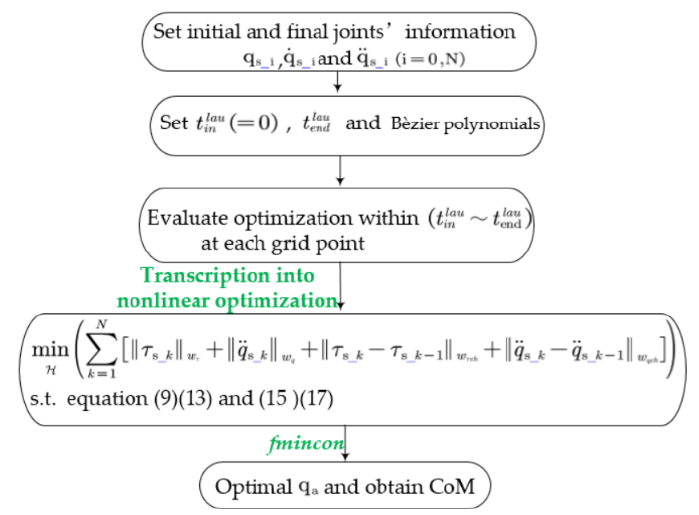
Figure 5. Optimization procedure.